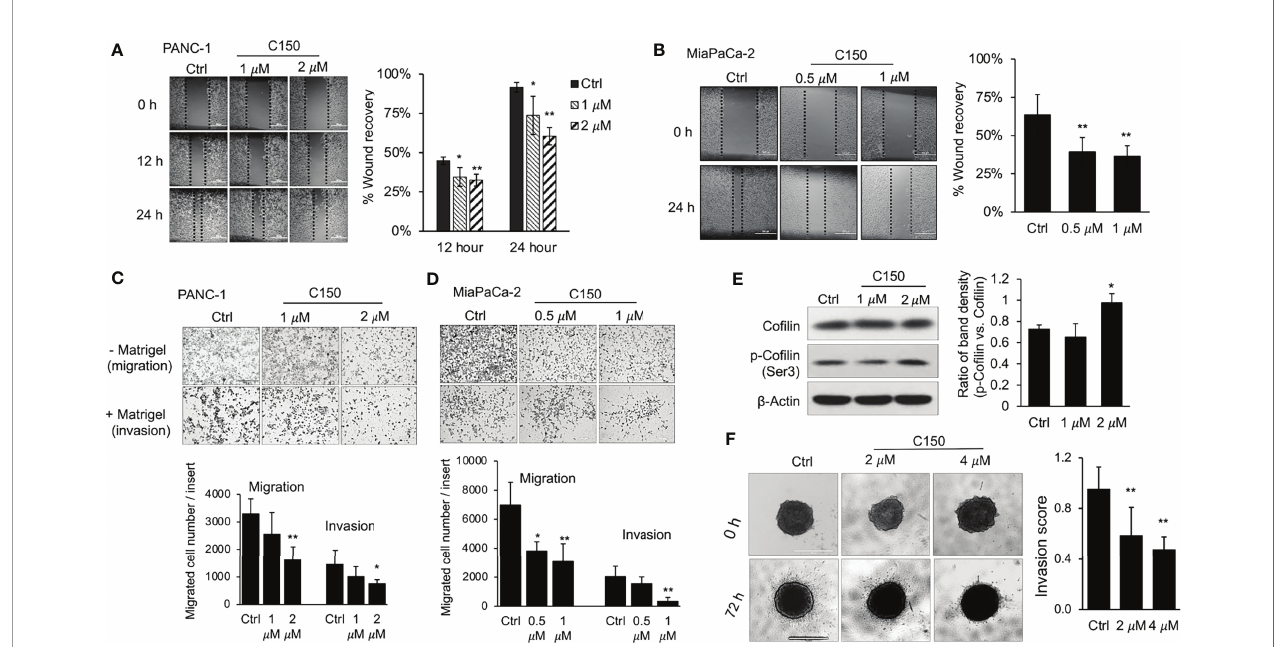
FIGURE 2 | C150 inhibits pancreatic cancer cell migration and invasion. (A, B) Wound healing assay. Monolayer of PANC-1 (A) cells were treated with DMSO (Ctrl) or C150 (1 and 2 m M) for 12 and 24 h after creating the wound. MIA PaCa-2 cells (B) were treated with DMSO (Ctrl) or C150 (0.5 and 1 µM) for 24 h after creating the wound. Scale bar, 500 µm. Bar graph shows percentage of wound recovery (mean ± SD of 4 repeats). (C, D) Transwell migration and invasion assays of (C) PANC-1 and (D) MIA PaCa-2 cells. Boyden chamber Transwell inserts were either uncoated (migration) or coated (invasion) with 0.1% Matrigel. Cells were treated with DMSO (Ctrl) or C150 (1 and 2 m M for 48 h for PANC-1 cells; and 0.5 and 1 m M for 24 h for MIA PaCa-2 cells). Bar graphs show the number of migrated or invaded cells per insert (mean ± SD of two independent experiments, each performed in triplicates). Scale bar, 500 µm. (E) Western blots of co fi lin and p-co fi lin. PANC-1 cells were treated with DMSO (Ctrl) or C150 (1 and 2 µM) for 24 h. Total cell lysates were subjected to immunoblotting against co fi lin and p-co fi lin (Ser3). b -Actin was blotted as loading control. Bar graph shows the ratio of p-Co fi lin (Ser3) band density to Co fi lin band density (mean ± SD of three independent experiments). (F) 3D invasion assay. PANC-1 cell spheroids were grown in collagen and treated with DMSO (Ctrl) or C150 (2 and 4 m M) for 72 h. Scale bar, 1000 µm. Bar graph shows invasion score (mean ± SD of two independent experiments, each performed in eight repeats) *P < 0.05, **P < 0.01 (vs. Ctrl) by one-way ANOVA followed by Tukey ’ s post hoc test. C150, 2-[2-(5-nitro-2-thienyl)vinyl]quinoline; Ctrl, control; p-,